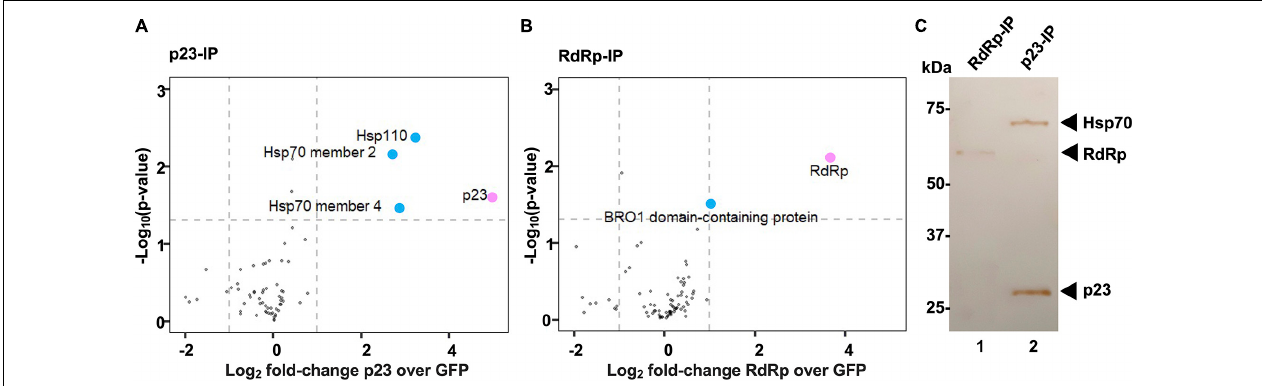
FIGURE 5 | Heat shock proteins interact with p23 but not the viral polymerase. (A,B) A quantitative proteomics approach (SILAC) was used to identify cellular interaction partners of p23 and the RNA-dependent RNA polymerase (RdRp) of RHDV, respectively. Proteins identified in at least two out of three biological replicates were included in the analysis. Cellular proteins significantly enriched in comparison to an internal GFP control are shown as blue dots; the viral bait proteins p23 and RdRp are highlighted in pink. Significance was analyzed using a one-sample t -test with an unadjusted p -value of < 0.05 and a log 2 fold-change > 1. Heat shock proteins Hsp70 and Hsp90 were identified as p23 interactors (A) , and one or more BRO1 domain-containing proteins were identified as RdRp interactors (B) . (C) Western blot analysis of immunoprecipitated complexes isolated from transfected cells expressing recombinant FLAG:p23 or FLAG:RdRp (p23-IP and RdRp-IP, respectively). Aliquots of affinity purified complexes were separated by SDS-PAGE and analyzed by Western blot using anti-FLAG and anti-Hsp70 antibodies. Hsp70 was detected in p23 but not in RdRp expressing cells (we did not attempt to detect Hsp110 or BRO1 domain-containing